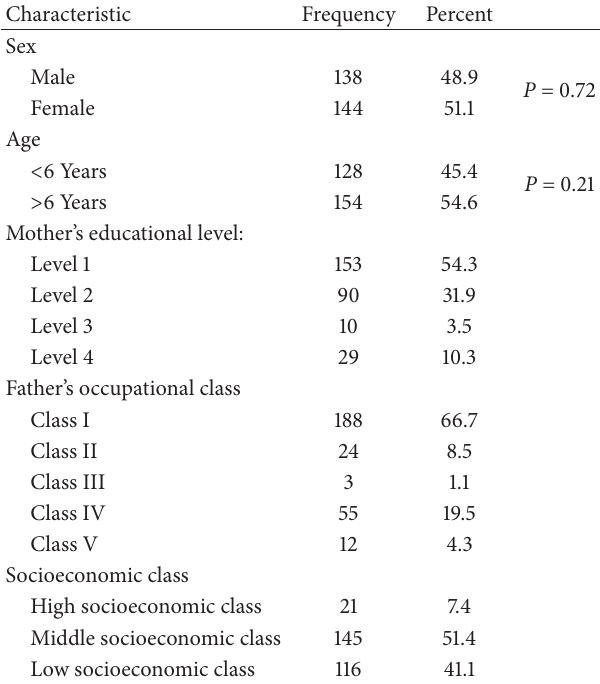
Table 1: Sociodemographic